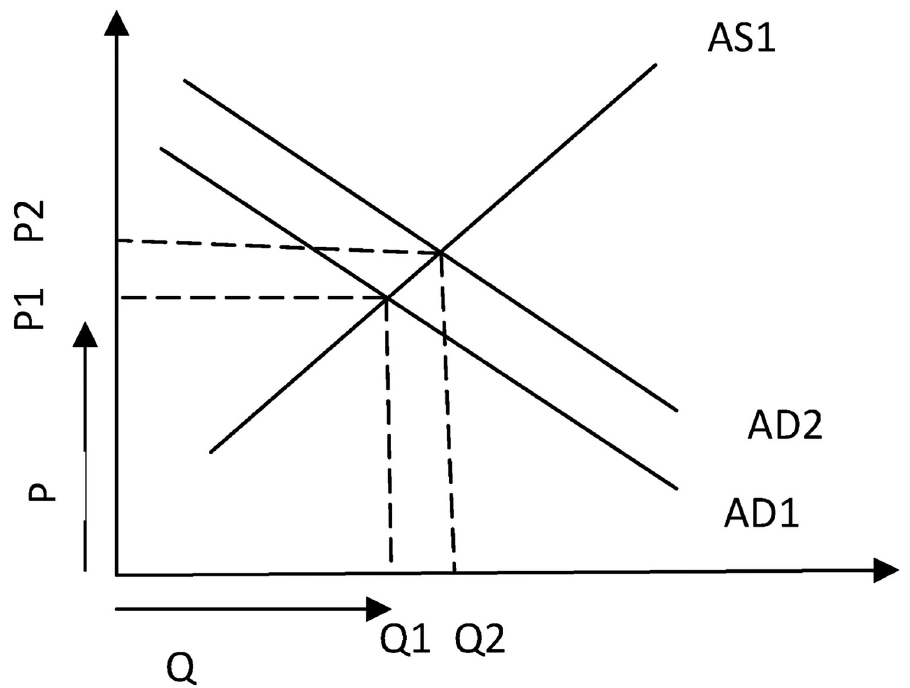
Fig 1. Impact of interest income on aggregate